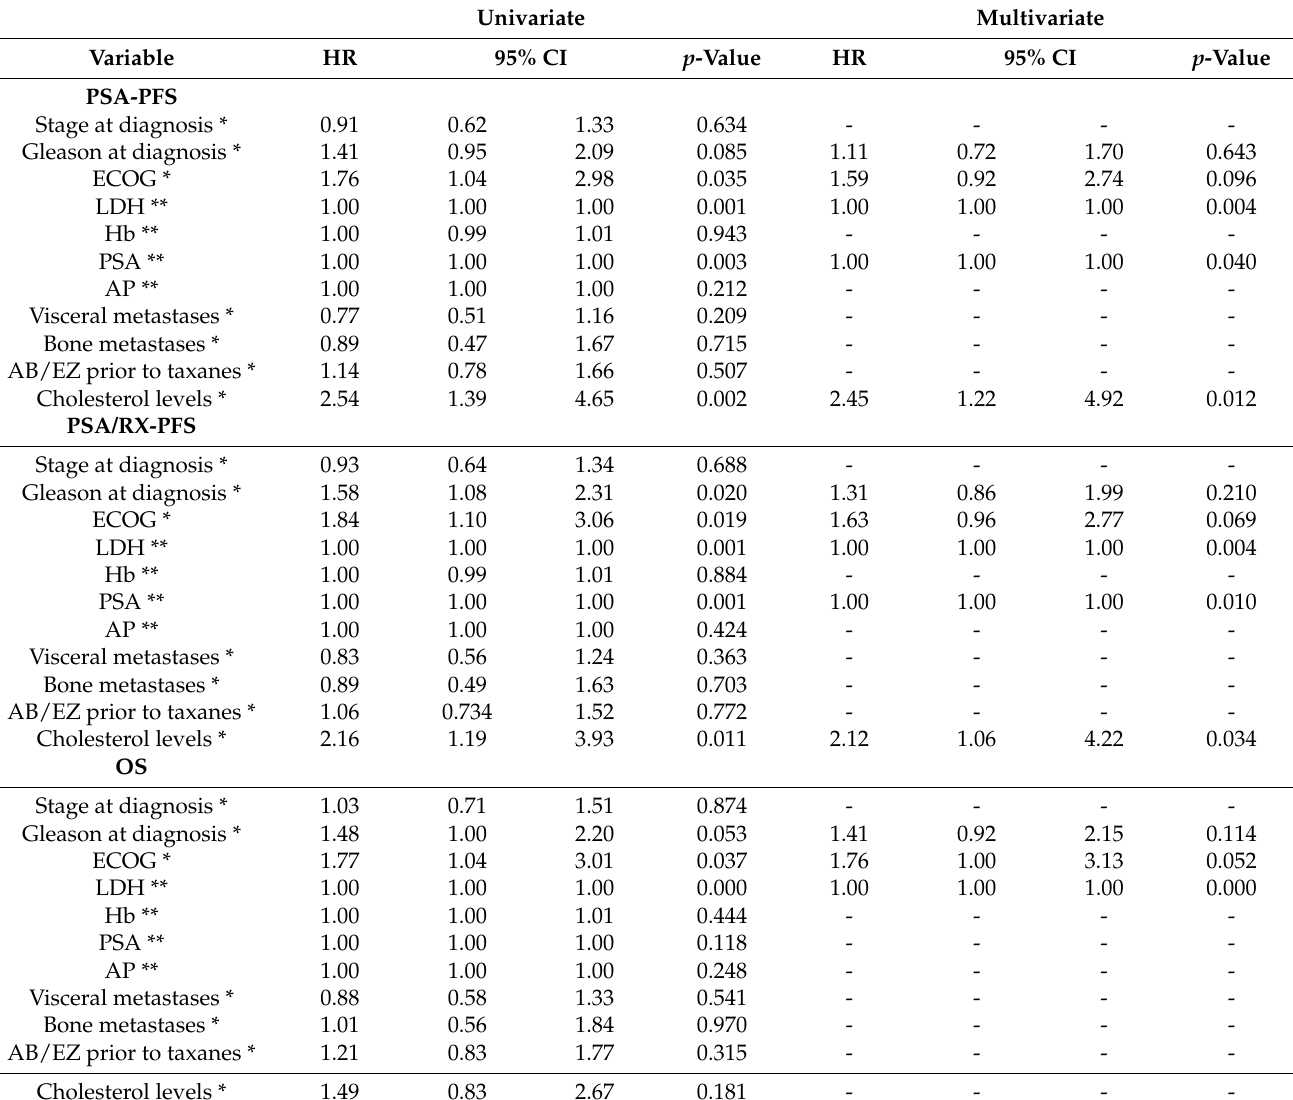
Table 4. Univariate and multivariate Cox models for PSA-PFS, PSA/RX-PFS and OS in patients from the plasma samples cohort, together with the validation cohort (global cohort), adjusted for clinically significant variables ( p < 0.1) in the univariate